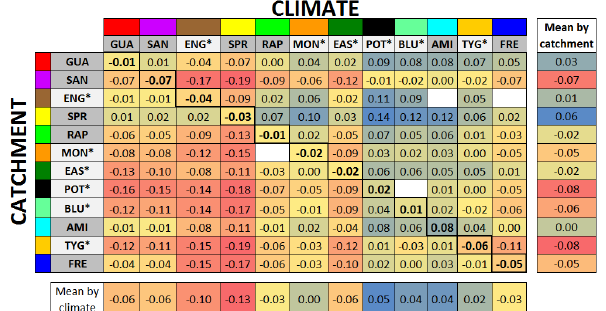
Figure 3 Fig. 3. 1E/P values for 12 climates filtered through 12 catchments. Values are averaged by rows (one catchment forced by 12 climates) and by columns (one climate filtered by 12 catchments) – Color scale ranges from red to blue denoting low to high 1E/P values,